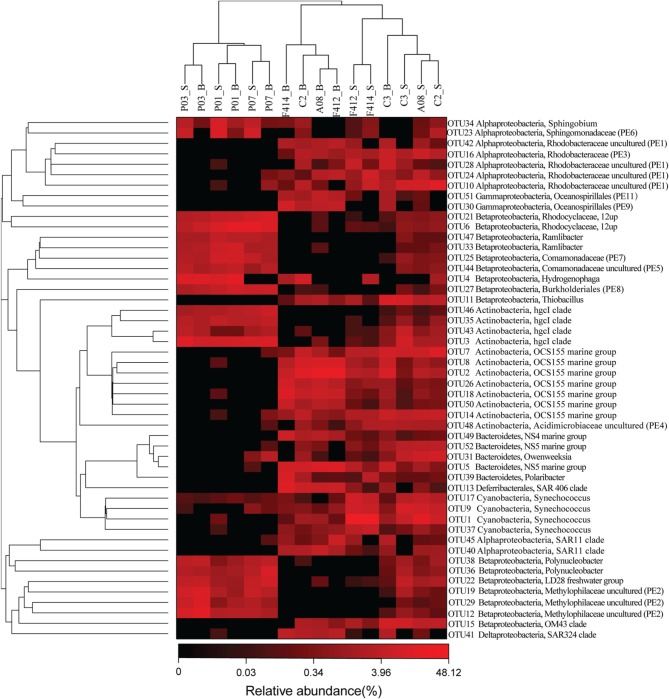
The heatmap of the top 50 abundant OTUs ranked from OTU1 to OUT52 according to abundance. OTU20 and OTU32 were removed because they belonged to chloroplast across all samples. Their phylogenetic relationships were shown on the right tree (constructed by FastTree using Maximum Likelihood method). The top tree showed the clustering relationship of samples. Eleven undefined clades were named as PE1-11, ranked by abundance. _S and _B standed for the surface and bottom water, respectively.